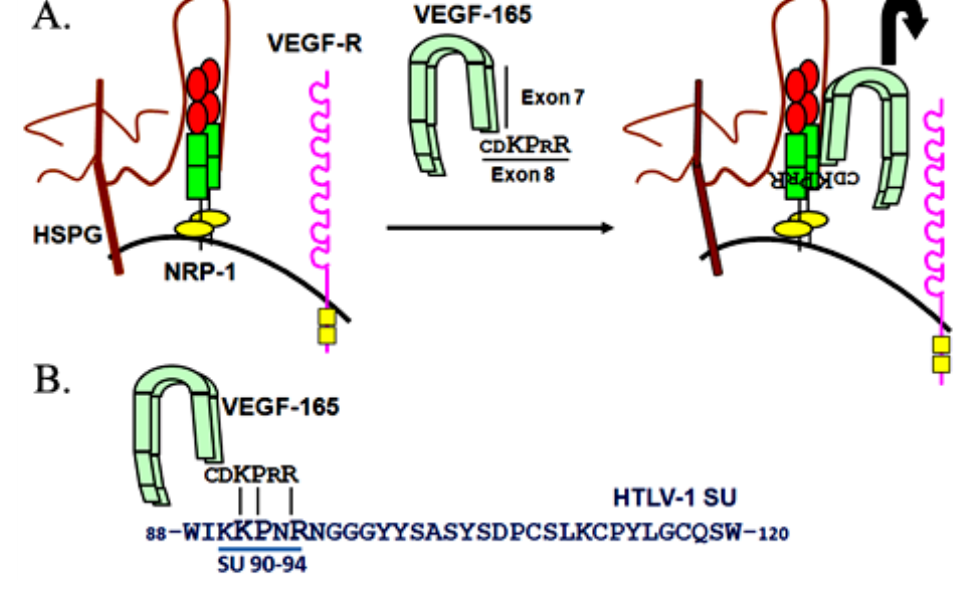
Figure 1. ( A ) Schematic representation of the binding of VEGF-165 to heparan sulfate proteoglycans (HSPG)/neuropilin-1 (NRP-1) complexes prior to interaction with the VEGF receptor. The position in VEGF-165 of the exon 7-encoded sequence, which binds to HSPGs, is indicated. The primary amino acid sequence of the exon 8-encoded sequence, which directly binds to the b domain of NRP-1, is also shown. The a, b and c domains of NRP-1 are painted in red, green or yellow, respectively. ( B ) Homology between the exon 8-encoded domain of VEGF-165 and the amino acid 90-94 region of the HTLV-1 surface subunit